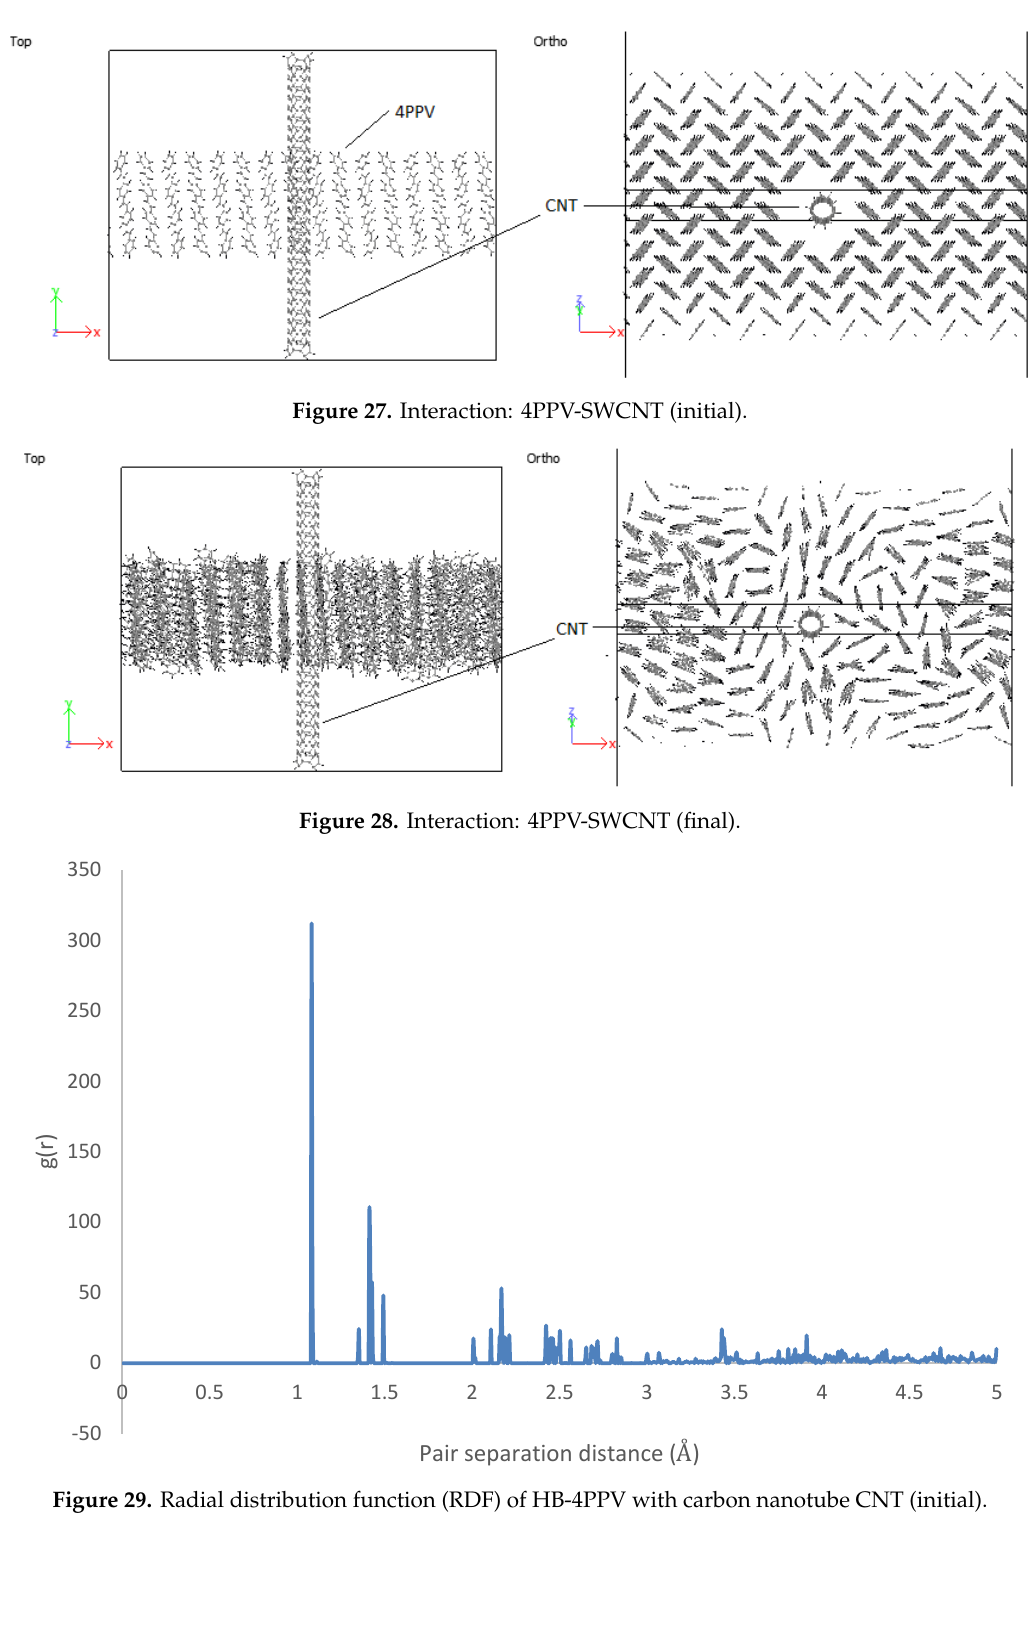
Figure 30. Radial distribution function (RDF) 4PPV with CNT (final). For the case of the radius of gyration, first the PPV supercell contracted and then expanded around the SWCNT. There was a net difference of ~ + 0.6 in the radius of gyration between the initial and final configurations (Figure 31), indicating that the system was more spread out than it initially started. Hence, there was less interfacial energy after the simulation.